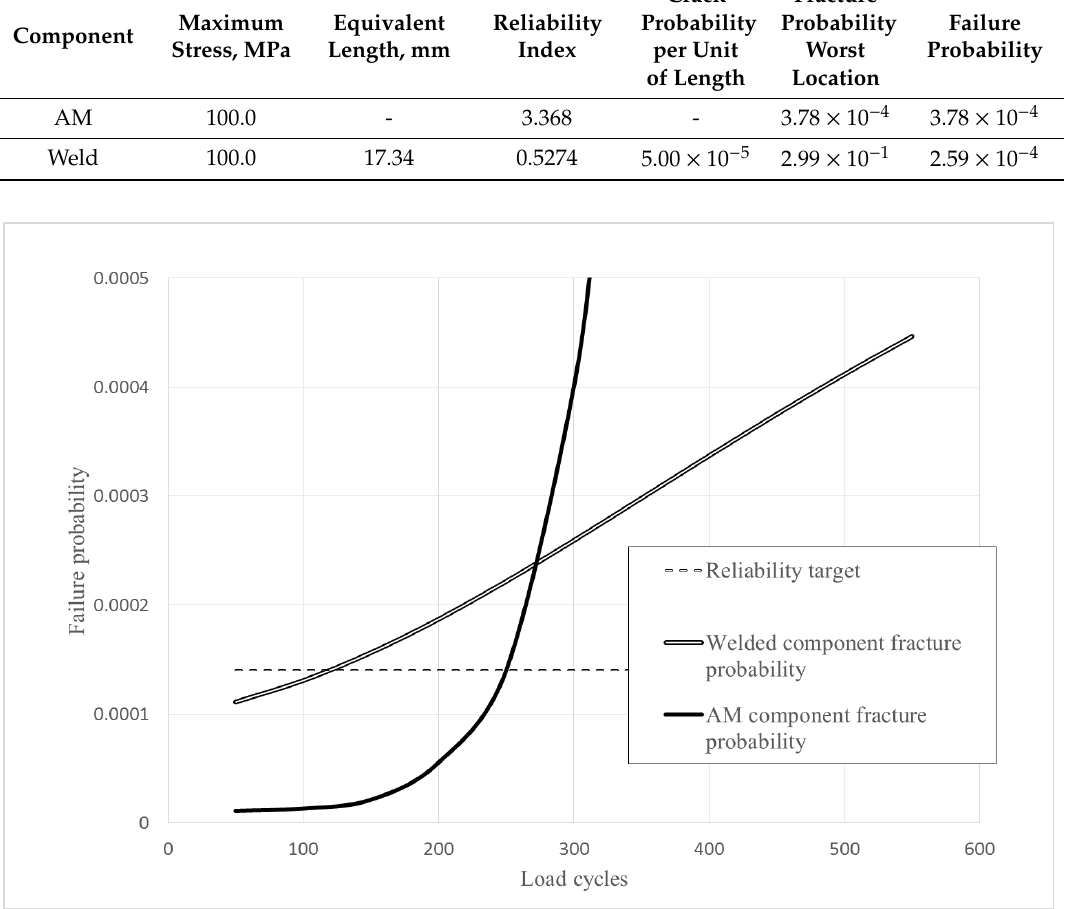
Figure 5. Failure probability without inspection.